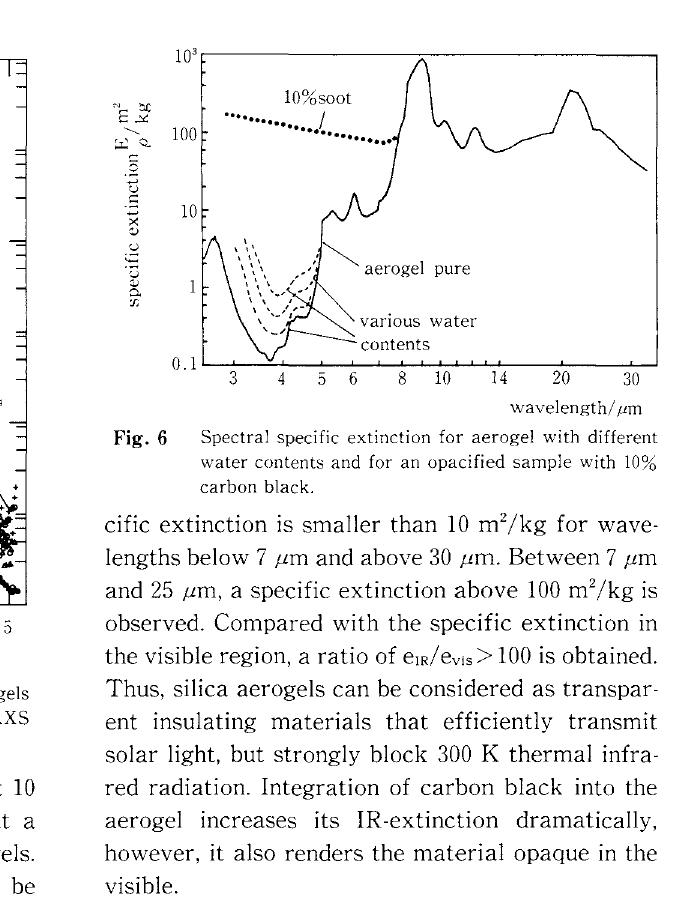
Fig. 6 Spectral specific extinction for aerogel with different water contents and for an opacified sample with 10% carbon